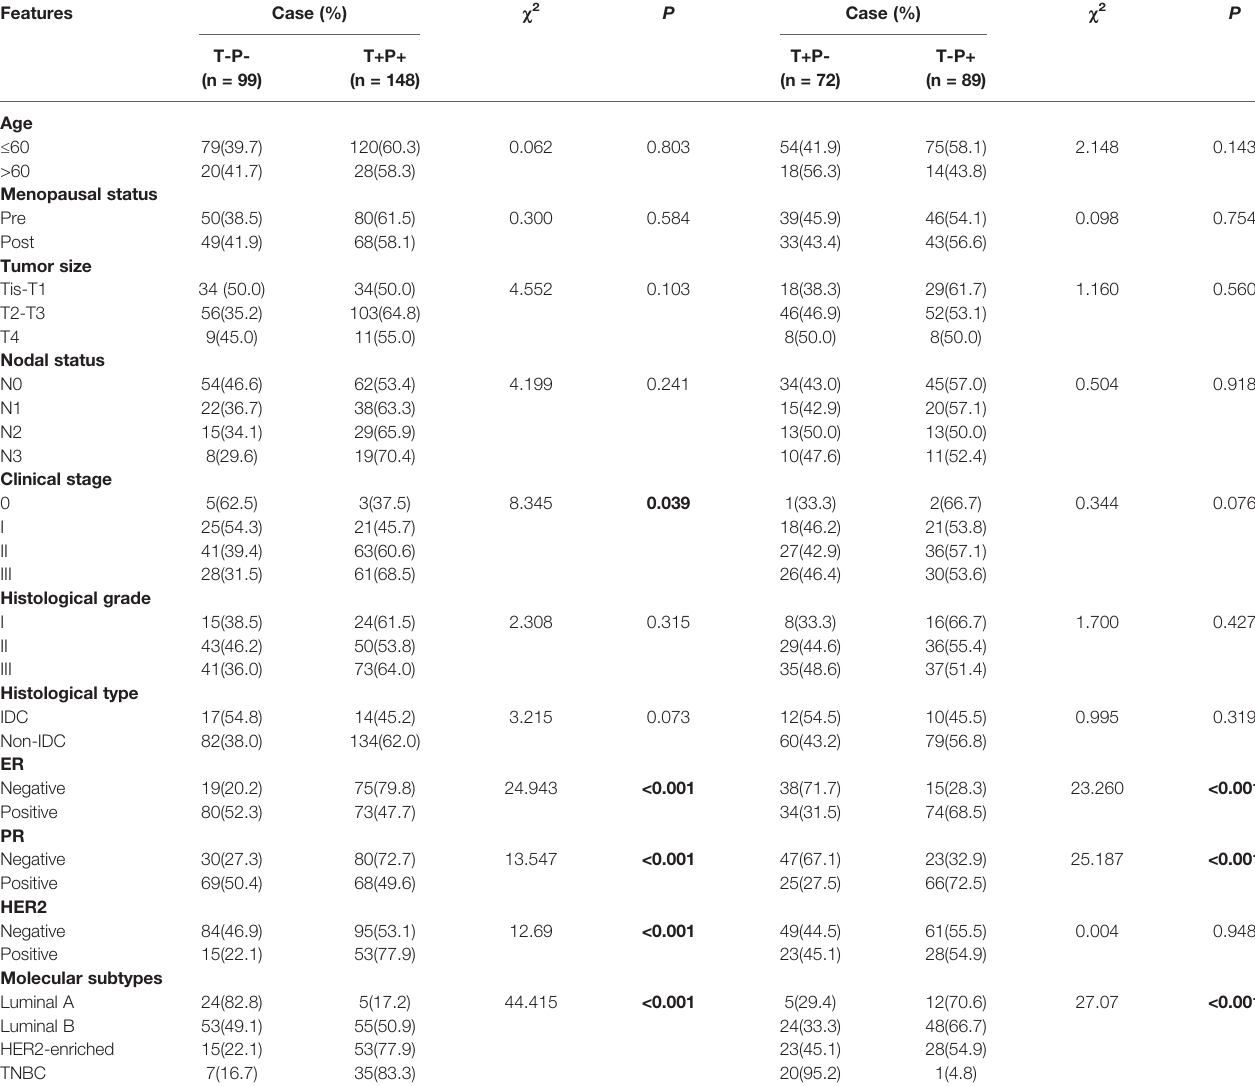
TABLE 3 | Correlations between mutant p53 and Twist1 expression and clinicopathologic parameters. Features